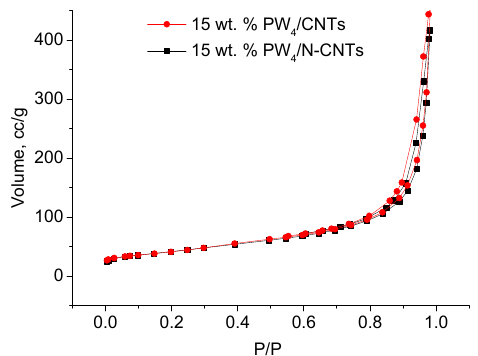
Figure 7. Nitrogen adsorption–desorption isotherms for 15 wt. % PW 4 /CNTs.